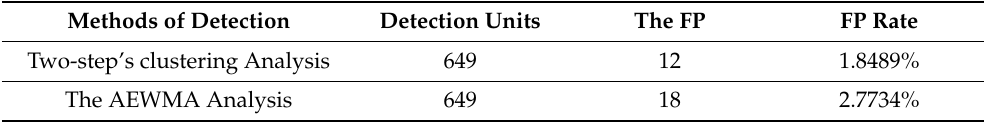
Figure 8. The TCP traffic of the false positive detection units. Table 4. The comparison of the proposed